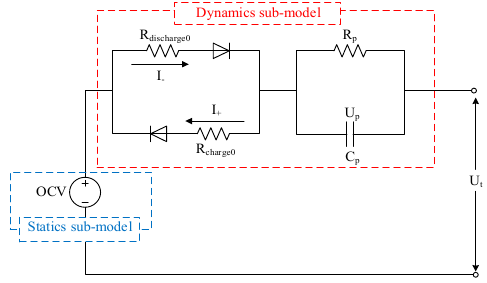
Figure 1. The equivalent circuit model (ECM) of the lithium ‐ ion battery.